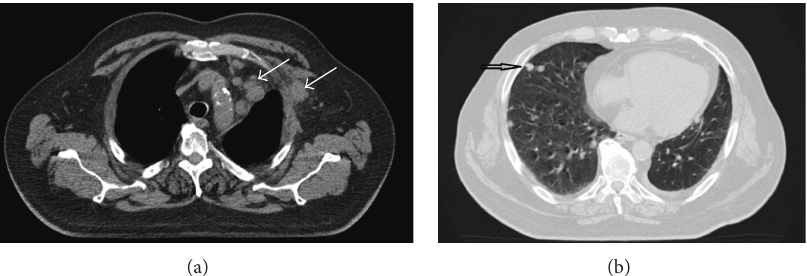
Figure 2: (a) Computed tomography scan of the thorax showing left-sided axillary nodal metastasis and mediastinal lymph node metastases. Status before palliative radiotherapy. (b) Computed tomography scan of the thorax showing right-sided pulmonary metastases (example of the patient’s bilateral metastases). During radiotherapy, this region received a cumulative dose of <